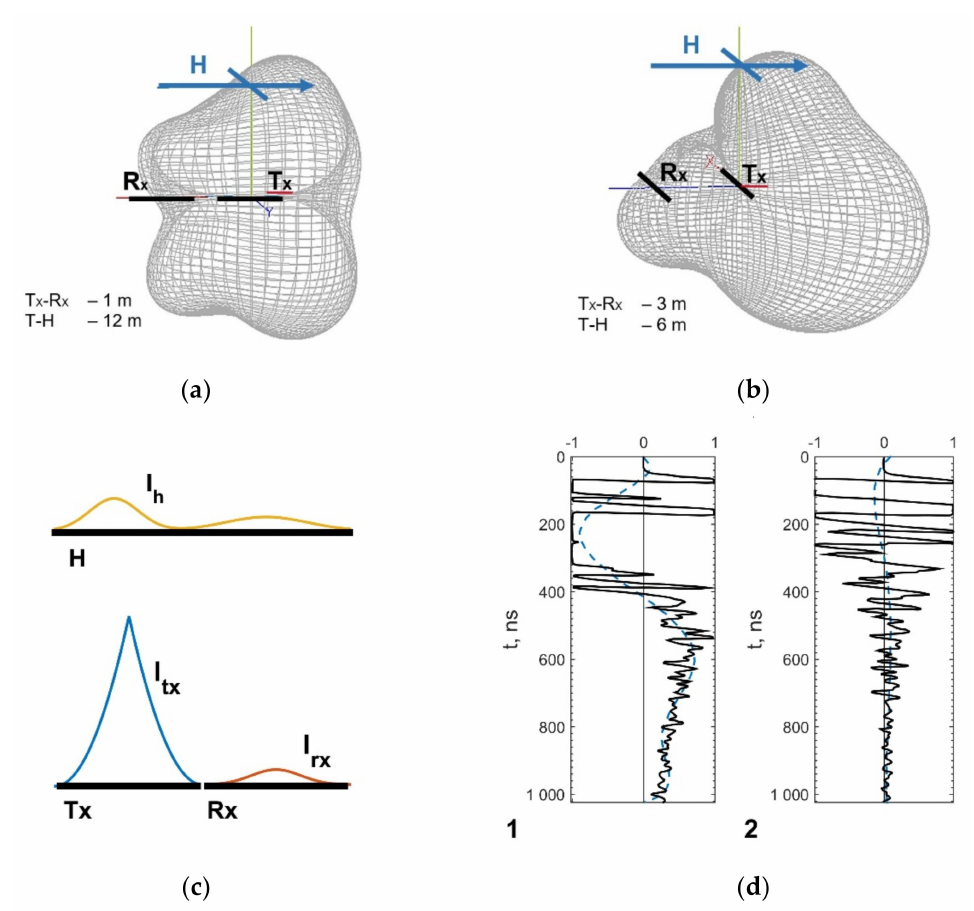
Figure 2. Modeling of GPR antenna radiation patterns at 25 MHz frequency: ( a ) in-line antennas design; ( b ) parallel antennas design; ( c ) current distribution Itx in Tx (blue line) and induced currents Irx in Rx (red line) and Ih in H (yellow line); ( d ) experimental GPR A-scans: ( 1 ) distance between the antennas equals half-wavelength; ( 2 ) antennas separation equals operating wavelength. Notations: Tx—transmitter antenna; Rx—receiver antenna; H—helicopter